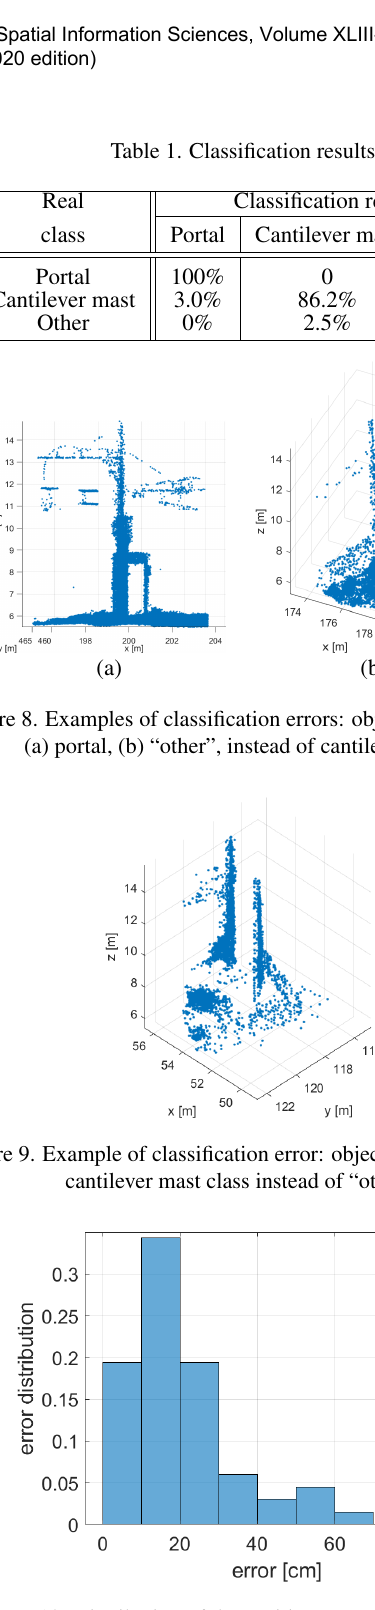
Figure 10. Distribution of the position error of the classified cantilever